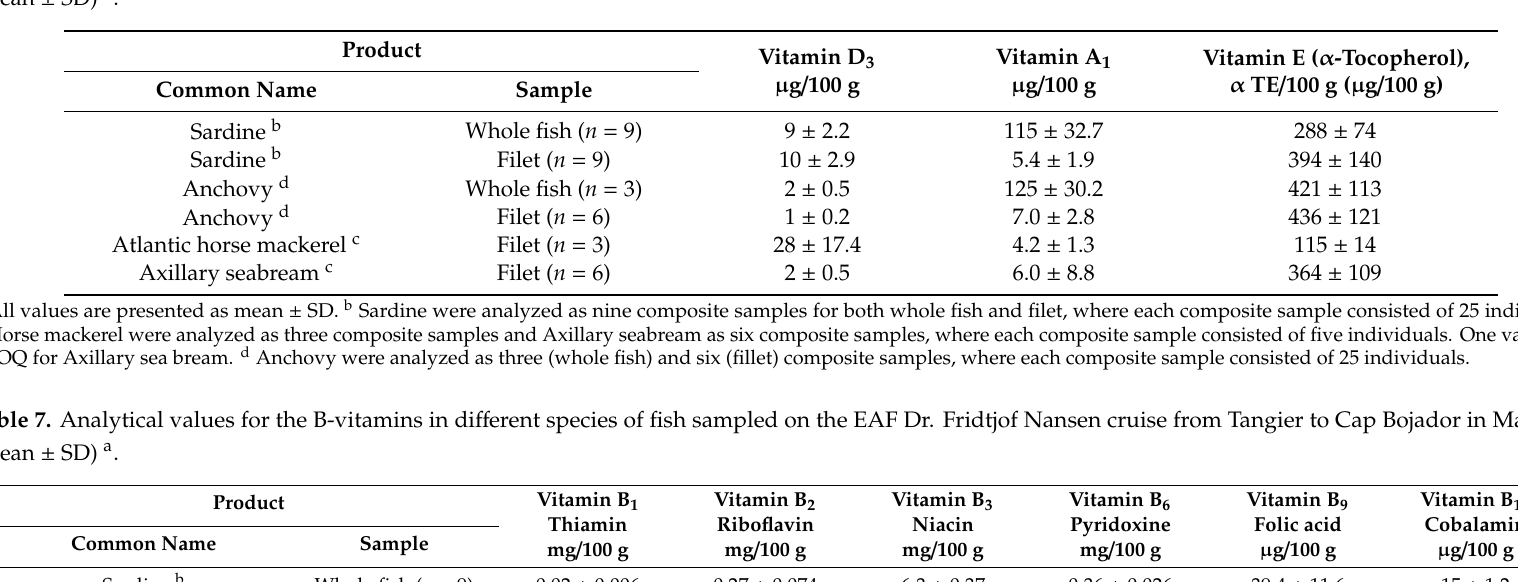
Table 6. Analytical values for selected vitamins in di ff erent species of fish sampled on the EAF Dr. Fridtjof Nansen cruise from Tangier to Cap Bojador in May 2017 (mean ± SD) a .